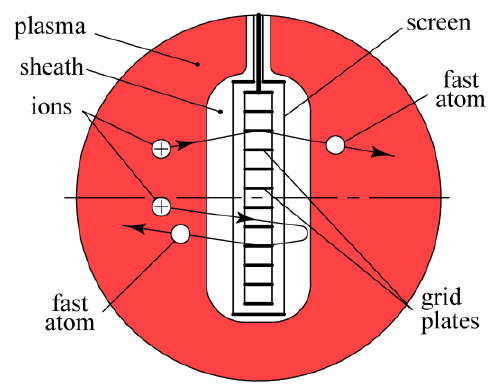
Figure 7. A schematic of fast atom formation due to the recombination of ions and electrons pulled by the ions from the grid out by the ions from the grid plates.